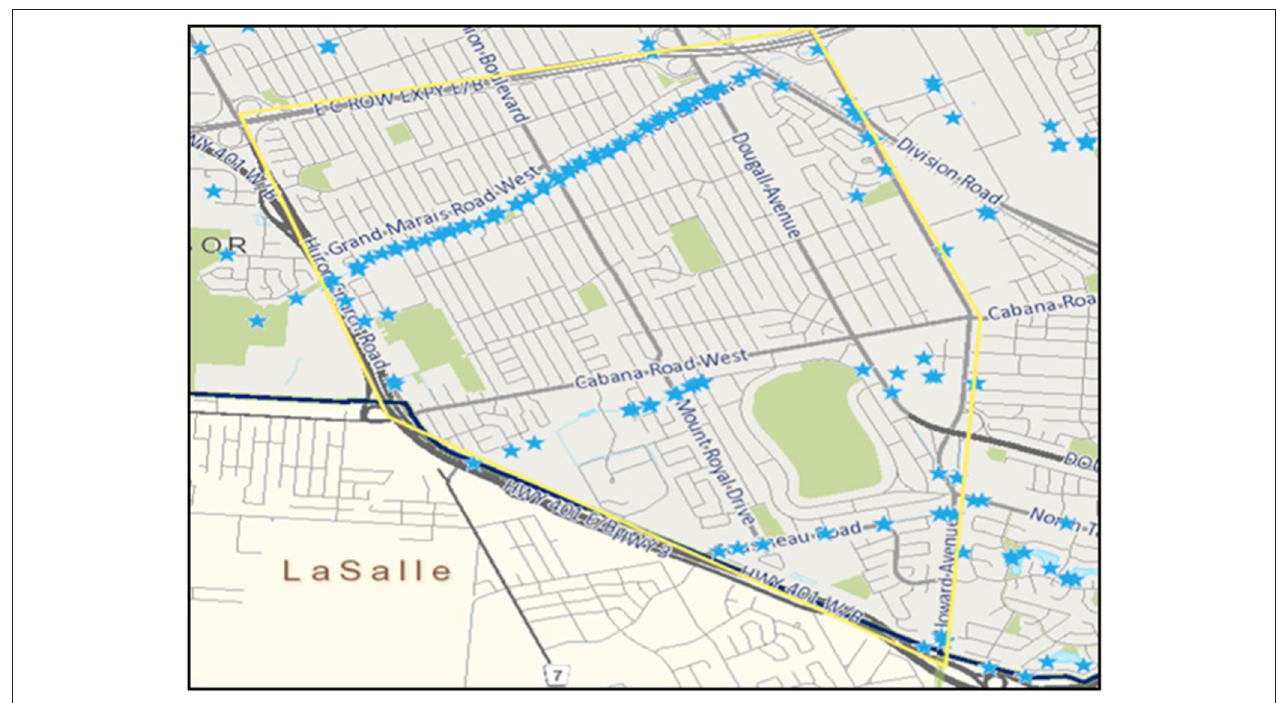
FIGURE 1 | South windsor